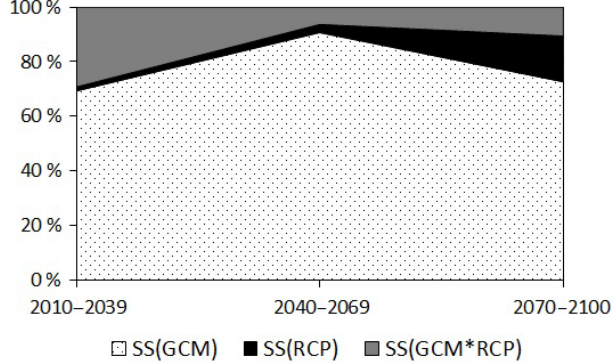
Figure 4. Sources of uncertainty in projected mean annual runoff anomalies for the Selenga River